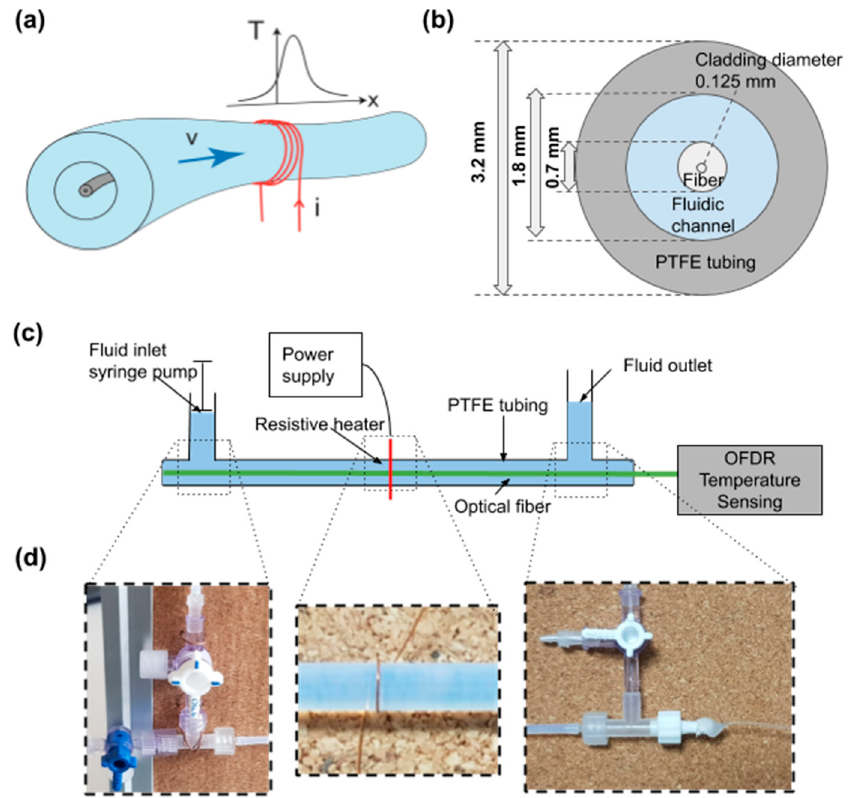
Figure 1. ( a ) Concept of flow monitoring using distributed optical fiber temperature sensing. A pulsed electric current ( i ) is applied to a copper coil wrapped around a fluidic conduit (red coil). Joule heating locally elevates the temperature ( T ) of the fluid propagating at a flow velocity ( v ). The optical fiber inserted in the fluidic conduit monitors the resulting temperature distribution T ( x , t ) . ( b ) Transverse cross-section of the fluidic conduit with an inserted optical fiber that defines the remaining area as resulting annular flow channel. ( c ) Schematic of the experimental setup. A syringe pump controls the fluid flow and optical frequency-domain reflectometry (OFDR) is used for distributed temperature sensing. ( d ) Close-up photographs highlight the easy-to-build implementation. From left to right shown are the fluidic inlet connecting to a syringe pump, the single copper coil as heating element, and the use of a fluidic T-connector (Swivel Luer Locks) to couple the fiber straight into the tubing without bending and risk to apply high strains. A hot gun glue seals off the tube and prevents leakage. The extra manual valves at the inlet and outlet help to rinse the conduit or exchange liquids quickly without using the syringe pump. To minimize gravitational pressure effects that could lead to back pressure, a wider diameter syringe without a piston was added as a reservoir at the fluid outlet.